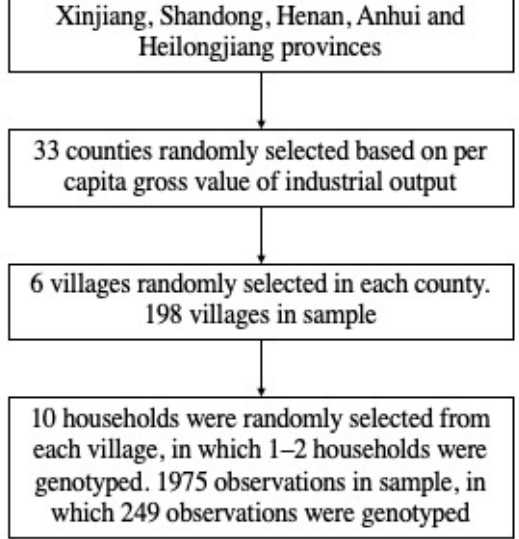
Figure 1. Diagram of household sample selection procedure.